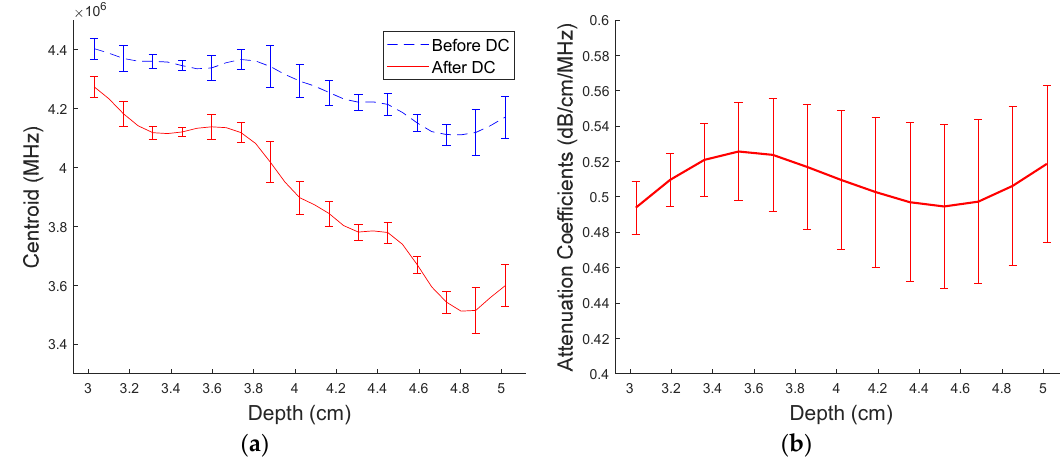
Figure 7. Results of spectral analysis of signal propagation through the p12 phantom: ( a ) Estimated variation of centroid with depth before (blue dotted line), and after (red solid line) DC. ( b ) Estimated attenuation coefficients. Appl. Sci. 2020 , 10 , x FOR PEER REVIEW 12 of 16